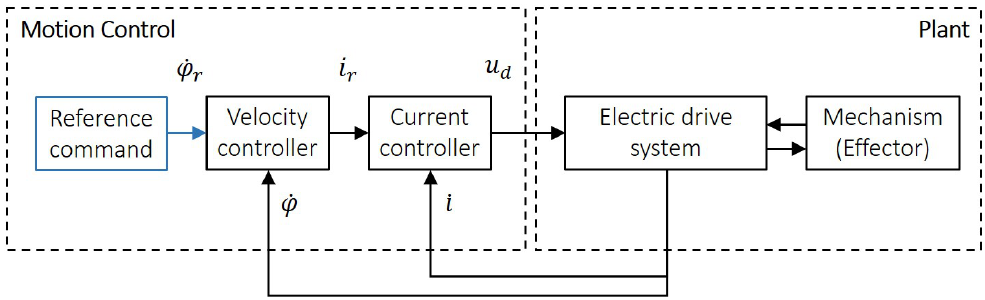
Figure 3. Conventional velocity control